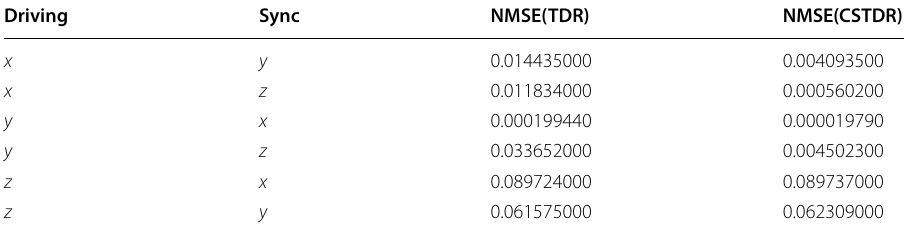
Table 1 Performance comparison of TDR and CSTDR computing for achieving chaos synchronization with Lorenz system